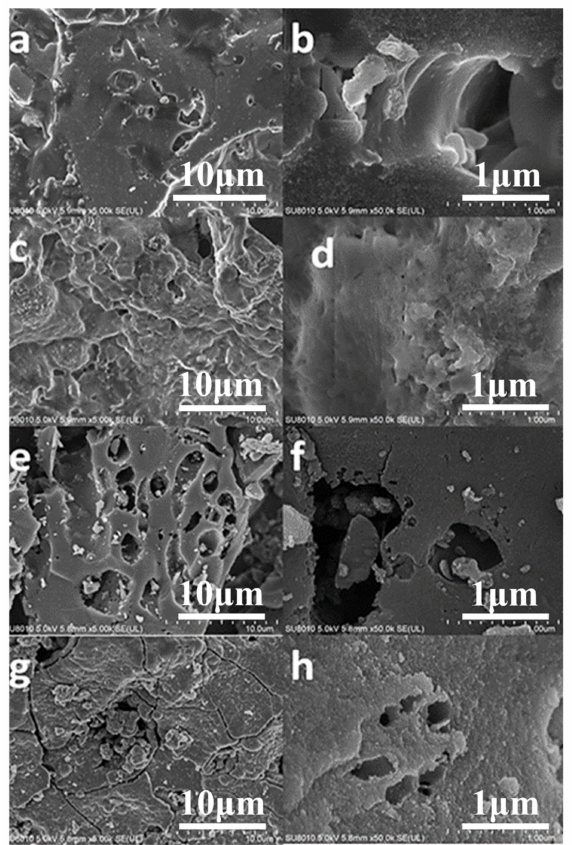
Figure 2. SEM images of crab shell biochar (( a , b ) are 800 − CSB; ( c , d ) are K − CSB; ( e , f ) are P − CSB; and ( g , h ) are M −